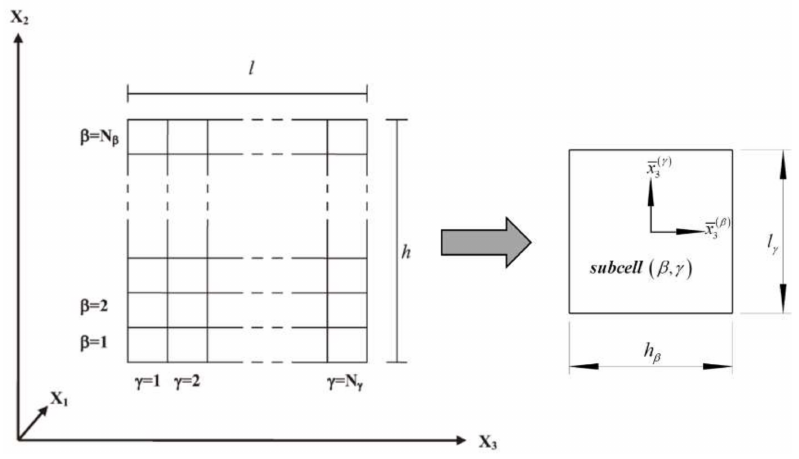
Figure 1. Discretization of the repeat unit